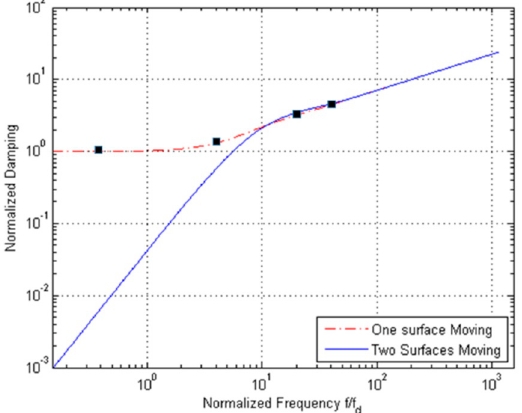
Figure 8. H = 3 µ m, stick BCs: comparison between the values of normalized damping for engaged Figure 8. 𝐻 = 3 μm , stick BCs: comparison between the values of normalized damping for engaged and disengaged and disengaged solutions.